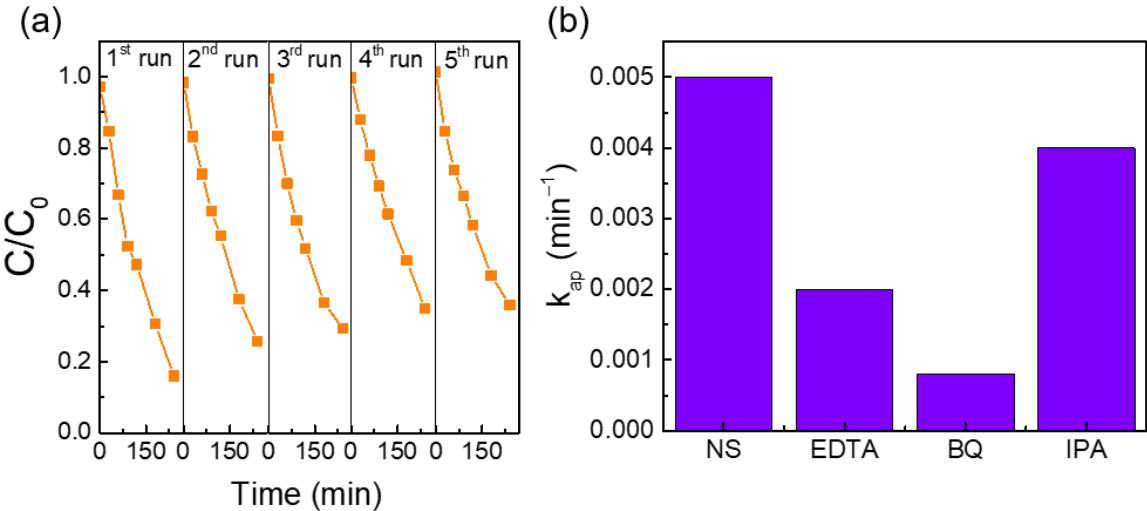
Figure 11. ( a ) MO degradation curves (C/C 0 as a function of the exposure time) in the presence of 30-GCN-T heterostructures up to 4 h under five consecutive cycles. The lines are for eye guidance only. ( b ) Comparison of the degradation rates of MO under solar simulating light using the 30-GCN-T heterostructure with no scavengers (NS) and 5 mL of water, and in the presence of trapping reagents (EDTA, BQ and IPA).